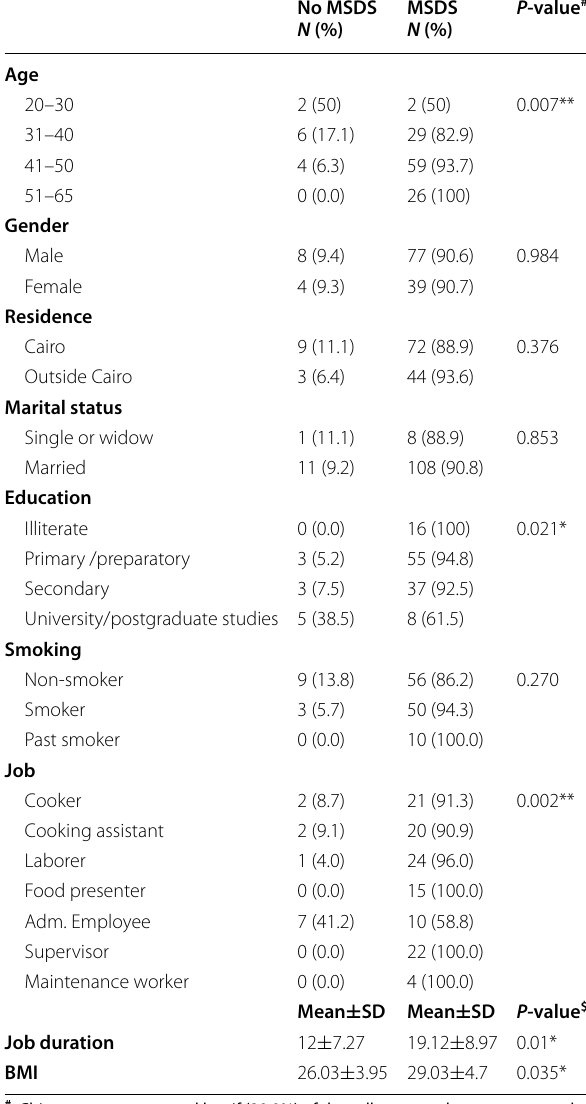
Table 4 Risk factors for MSDs among participating kitchen workers ( n =